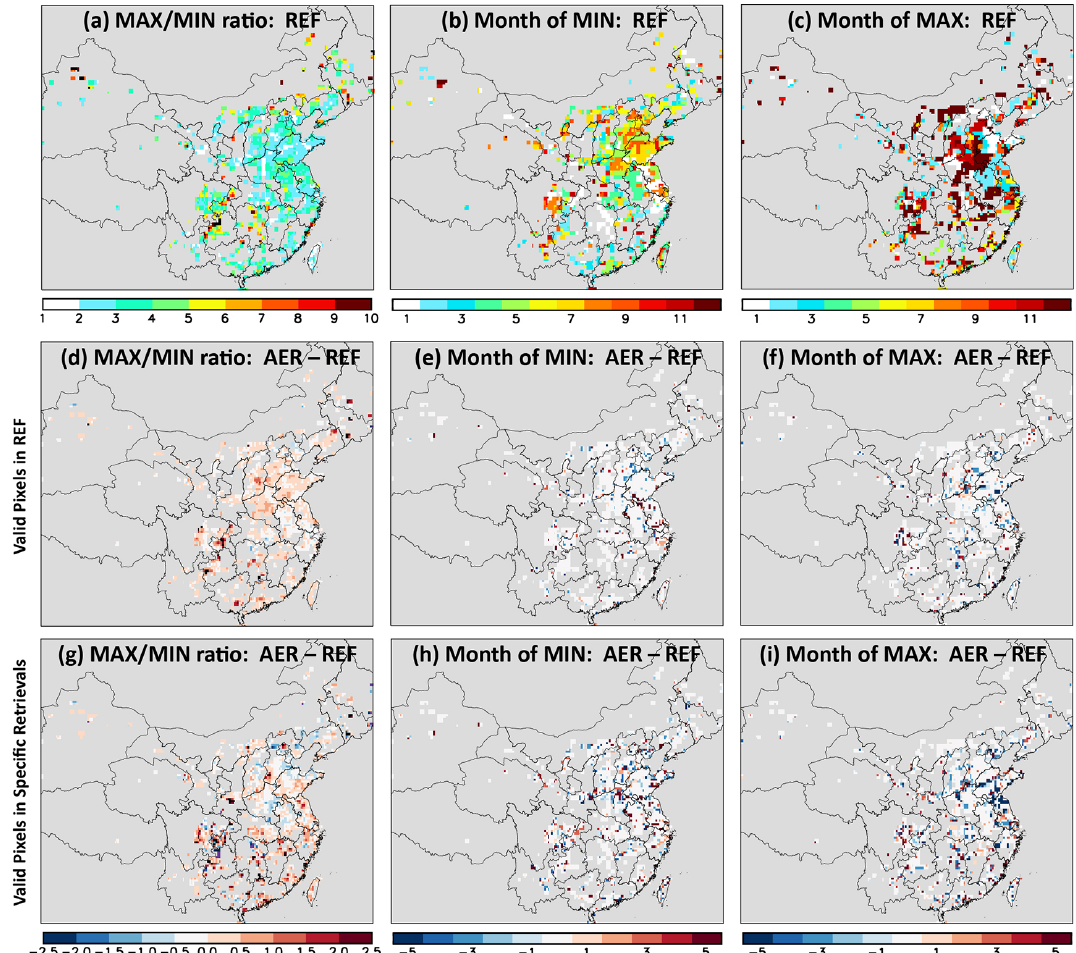
Figure 14. (a) The maximum to minimum ratio for monthly a posteriori anthropogenic emissions in case REF, and the months of (b) min- imum and (c) maximum emissions. (d–f) Differences between cases AER and REF; OMI pixels are selected only when valid in case REF. (g–i) are similar to (d–f) but with respect to pixels valid in individual retrieval cases. Provincial boundaries of China are shown. Values outside the upper (lower) bound of color intervals are shown in black (purple). In (d–i) , areas with emissions below 0.5 × 10 15 cm − 2 h − 1 are masked. In (e) , (f) , (h) and (i) , the month proceeds in loop; i.e., November (January) is 1 month behind (ahead of)